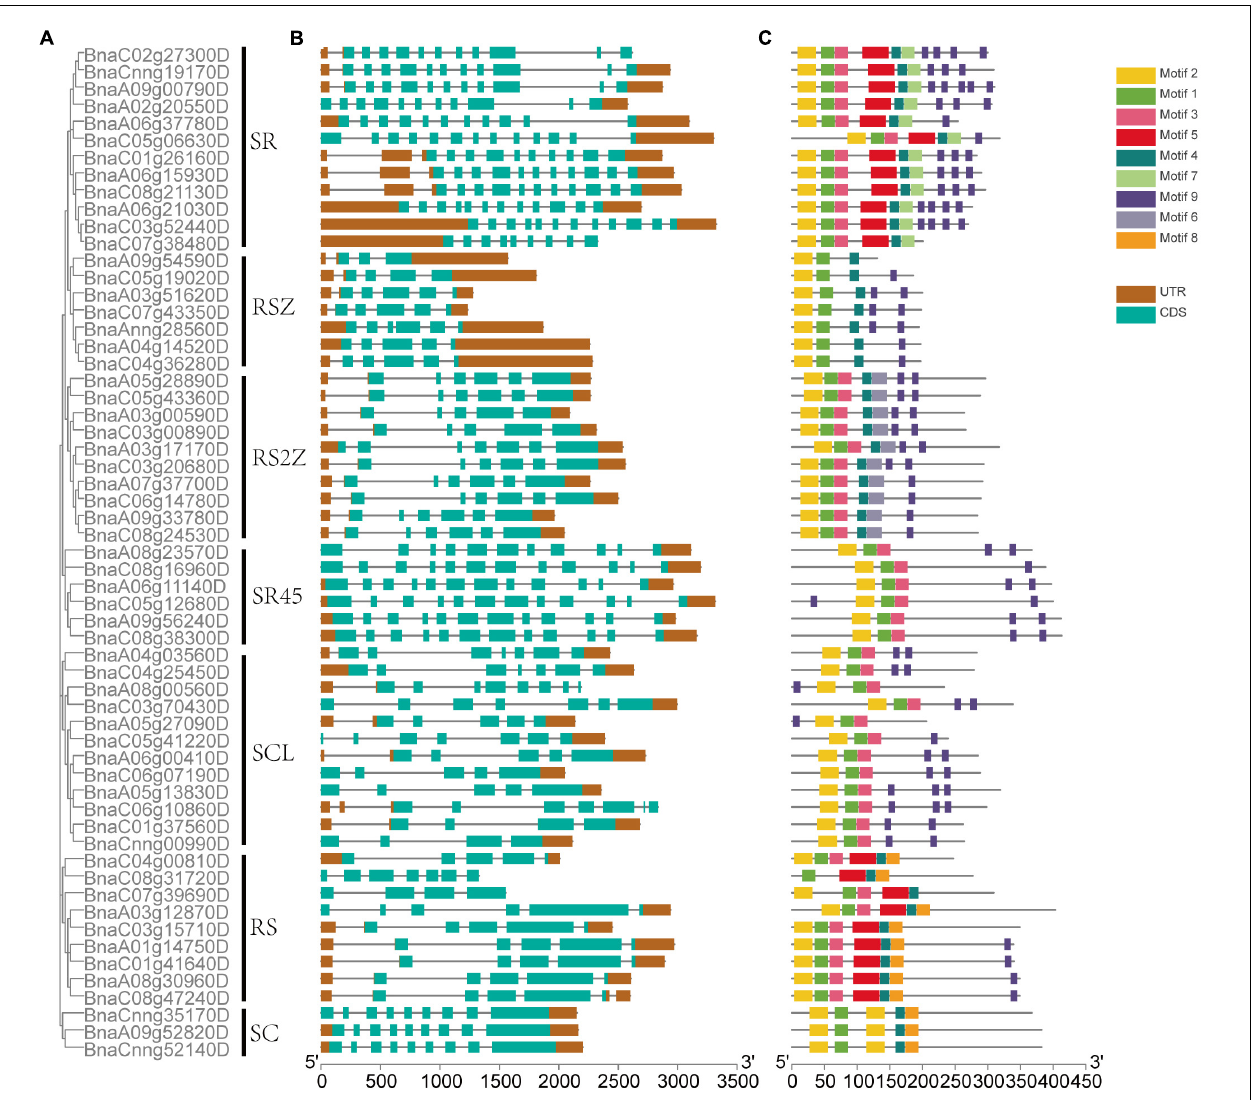
FIGURE 3 | The phylogenetic relationship, gene structure, and conserved motifs of SR genes in B. napus . (A) The phylogenetic relationships of 59 SR proteins based on the NJ method. (B) Gene structures of the SR genes. Dark brown boxes represented UTR, and indigo boxes represented CDS. (C) The motif composition of SR proteins. Numbers 1–9 were displayed in different colored